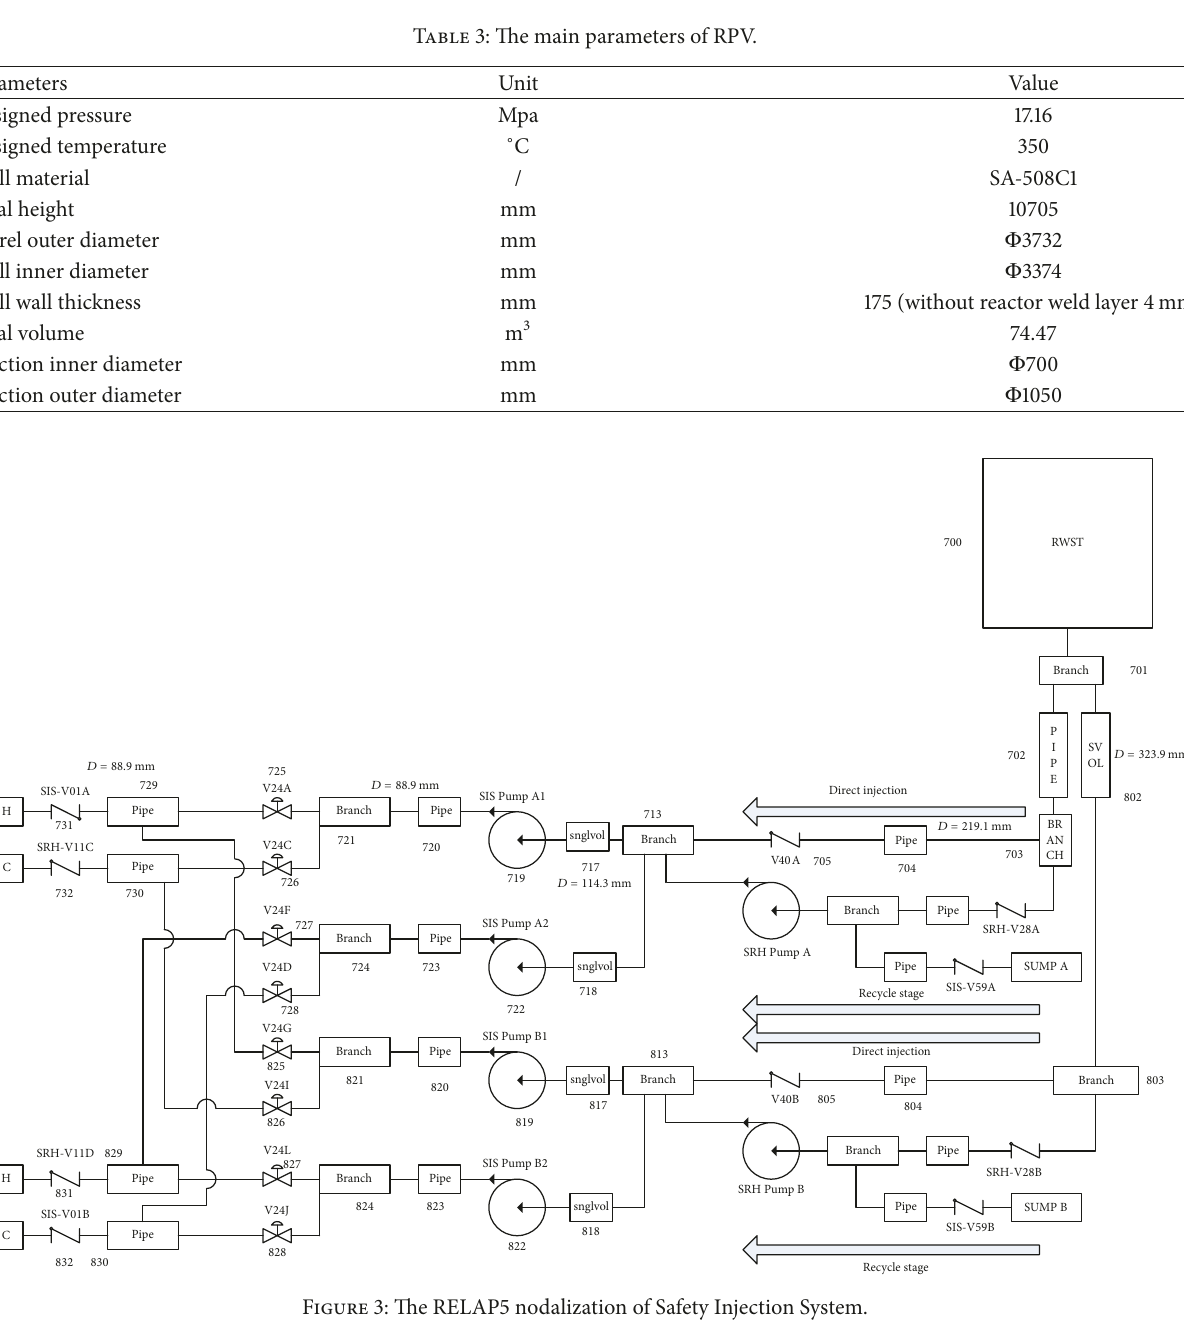
Figure 3: The RELAP5 nodalization of Safety Injection